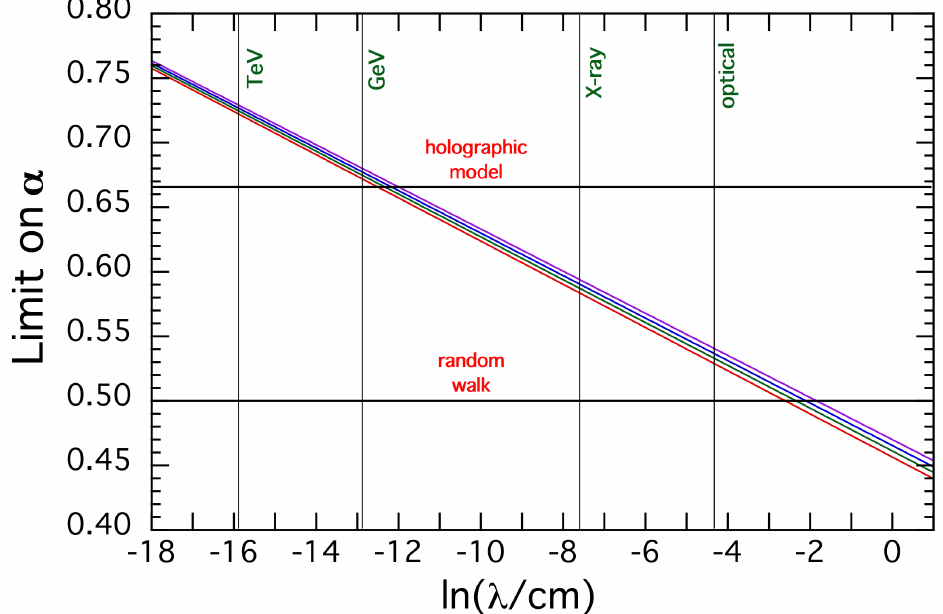
Figure 1. Constraints on the parameter α , for four different comoving distances to a distant source, 425 Mpc ( z ≈ 0.1; red curve), 1 Gpc ( z ≈ 0.25; green), 3 Gpc ( z ≈ 1; blue) and 10 Gpc ( z ≈ 12; purple). The vertical dashed lines represent the optical (5000 Å), X-ray (5 keV), GeV and TeV wavebands. Since images of cosmologically distant sources betray no evidence of phase fluctuations that might be introduced by spacetime foam, there is a large region of parameter space excluded by the obeservations, denoted by the regions below the